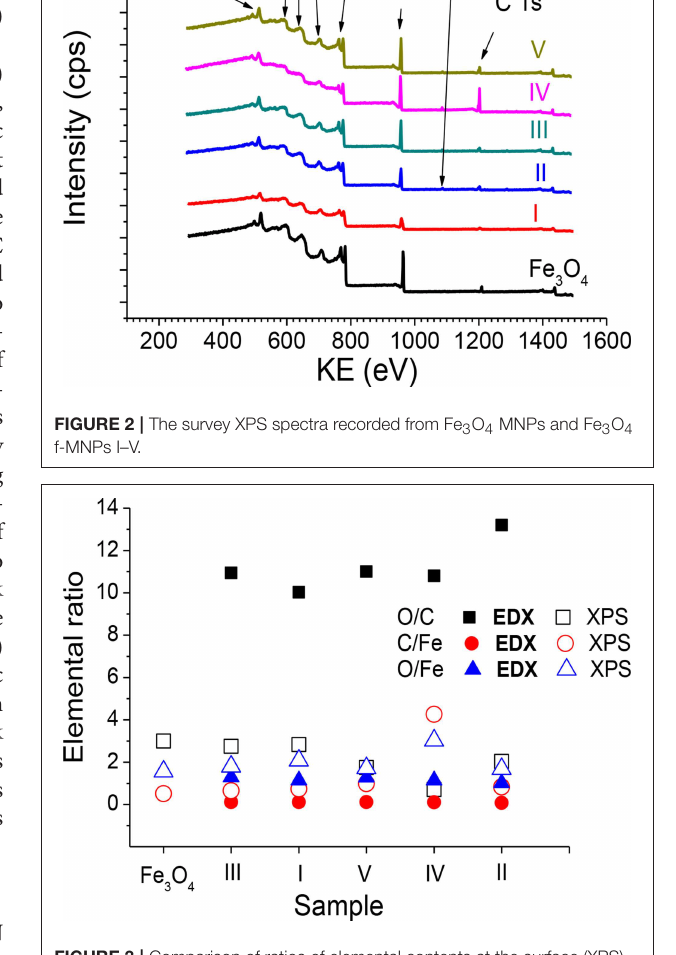
FIGURE 3 | Comparison of ratios of elemental contents at the surface (XPS) and in the bulk (EDX) ( Rangam et al., 2017) of Fe 3 O 4 and Fe 3 O 4 f-MNPs I–V. Sample f-MNPs I–V are listed in the order of decreasing